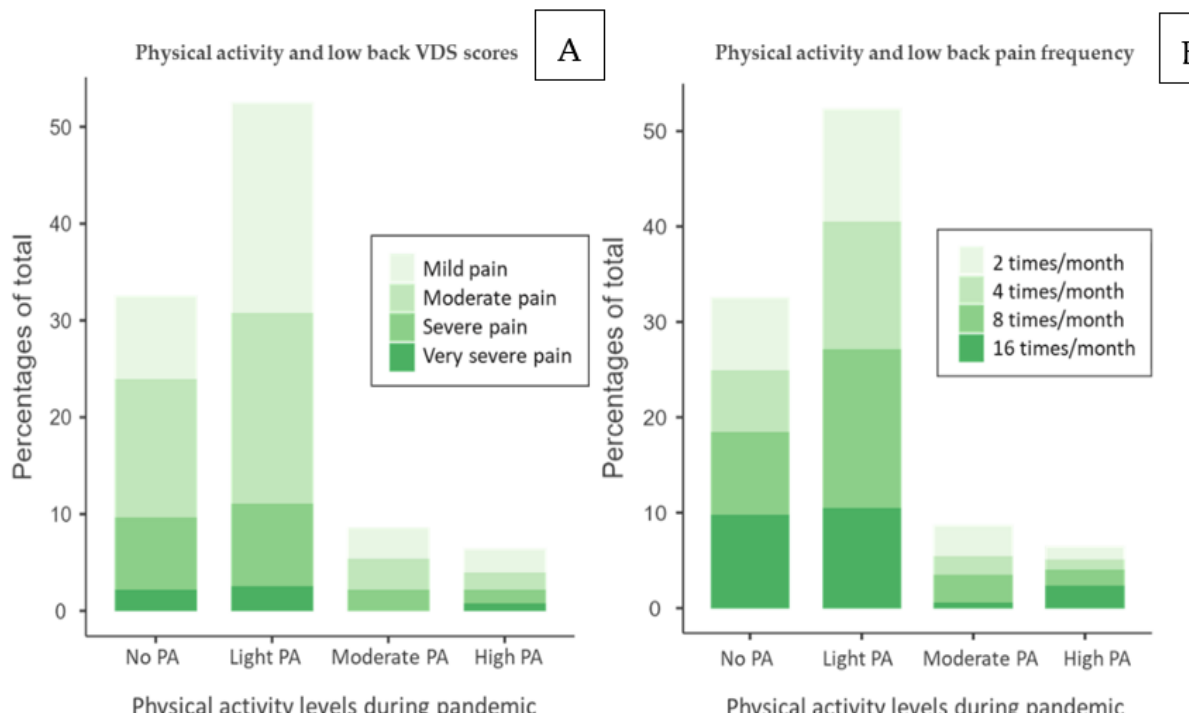
Figure 4. ( A ) Stacked bar of VDS low back score and physical activity levels and ( B ) stacked bar of pain frequency and physical activity levels. No PA: no physical activity, Light PA: physical activity <140 min/week, Moderate PA: (cid:39) 150 min/week, High PA: >200